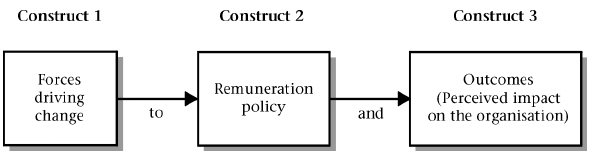
Figure 1: Inter-relatedness of research constructs The dependent variable is outcomes in the form of perceived impact on the organisation. Respondents indicated whether the remuneration policy changes had a positive or negative impact on the organisation. A list of factors driving remuneration policy decisions was presented to respondents who indicated the extent to which each factor drove remuneration policy decisions in their